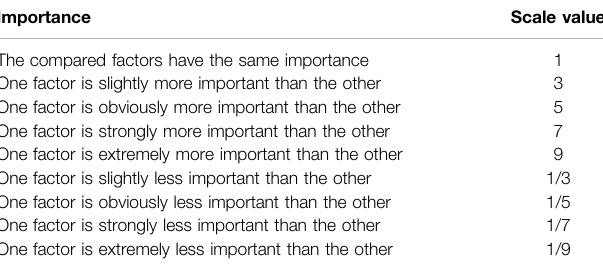
TABLE 5 | Assignment of scale